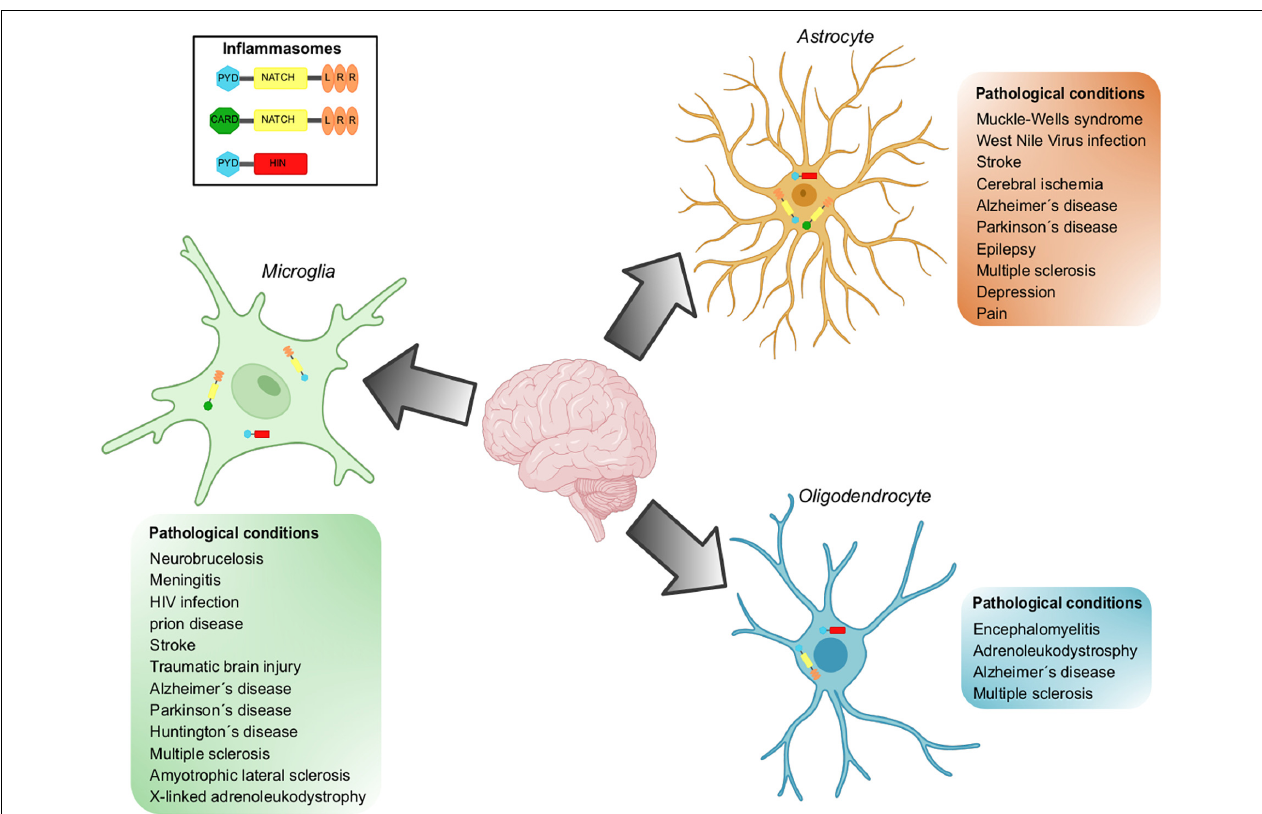
FIGURE 3 | Inflammasomes implicated in pathological conditions in glial cells. Inflammasomes can be activated in the CNS in response to different stressors. Inflammasome activation has been demonstrated in resident cell types of the CNS, including microglia, astrocytes, and oligodendrocytes. NLRP3, NLRCs and AIM are the inflammasomes located in glial cells and whose participation has been demonstrated in a wide variety of pathological conditions.